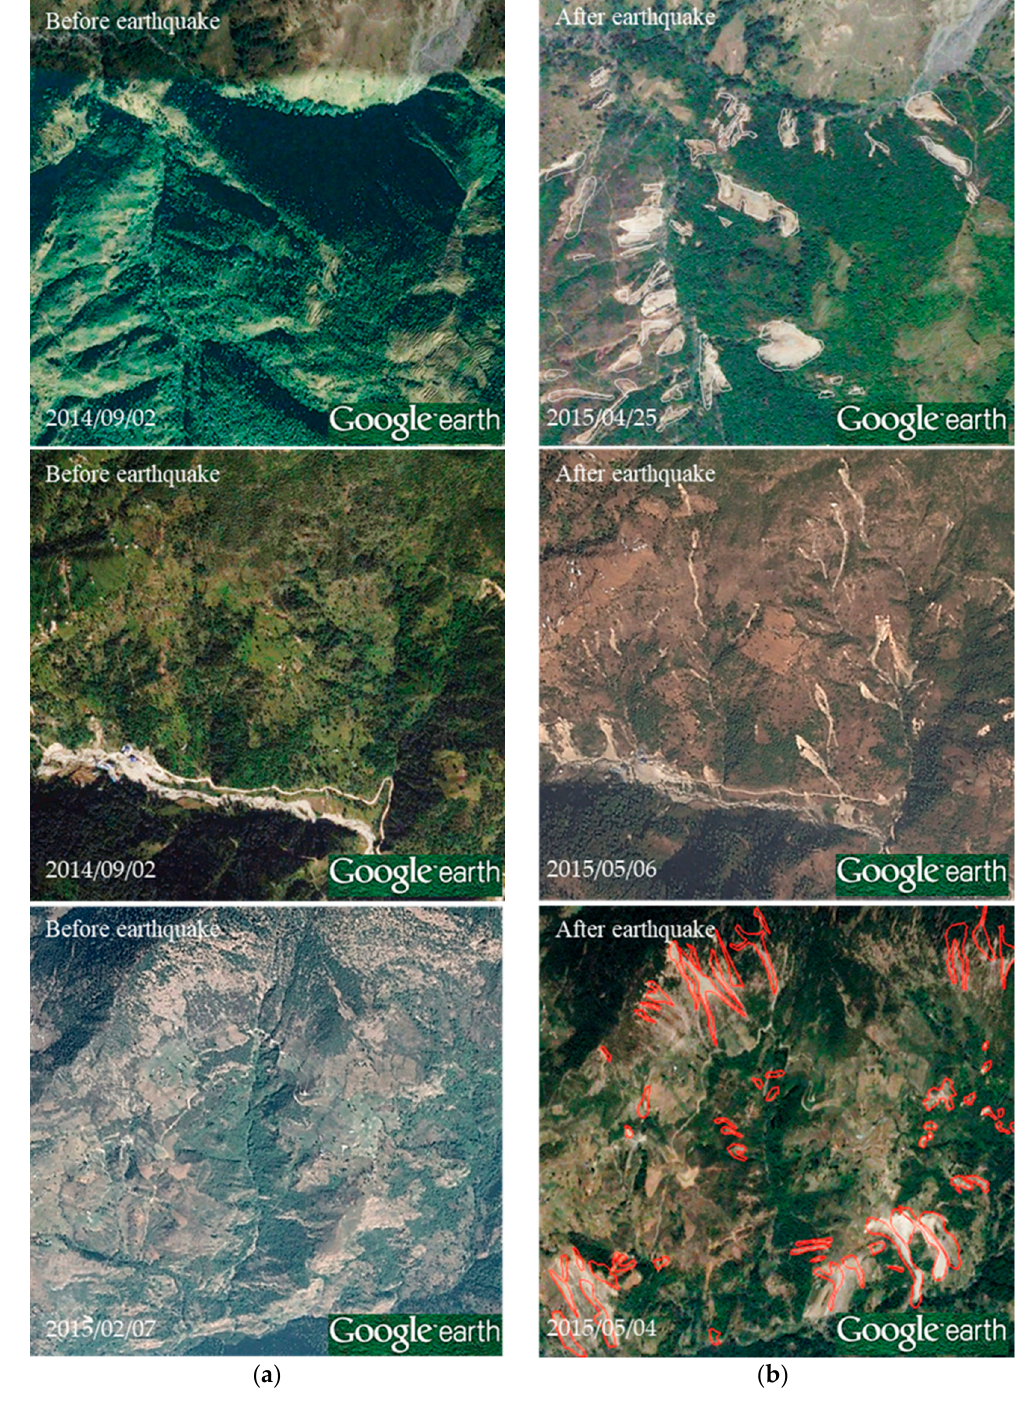
Figure 2. Google Earth images of landslides triggered by the earthquake: ( a ) before; ( b ) after the event.